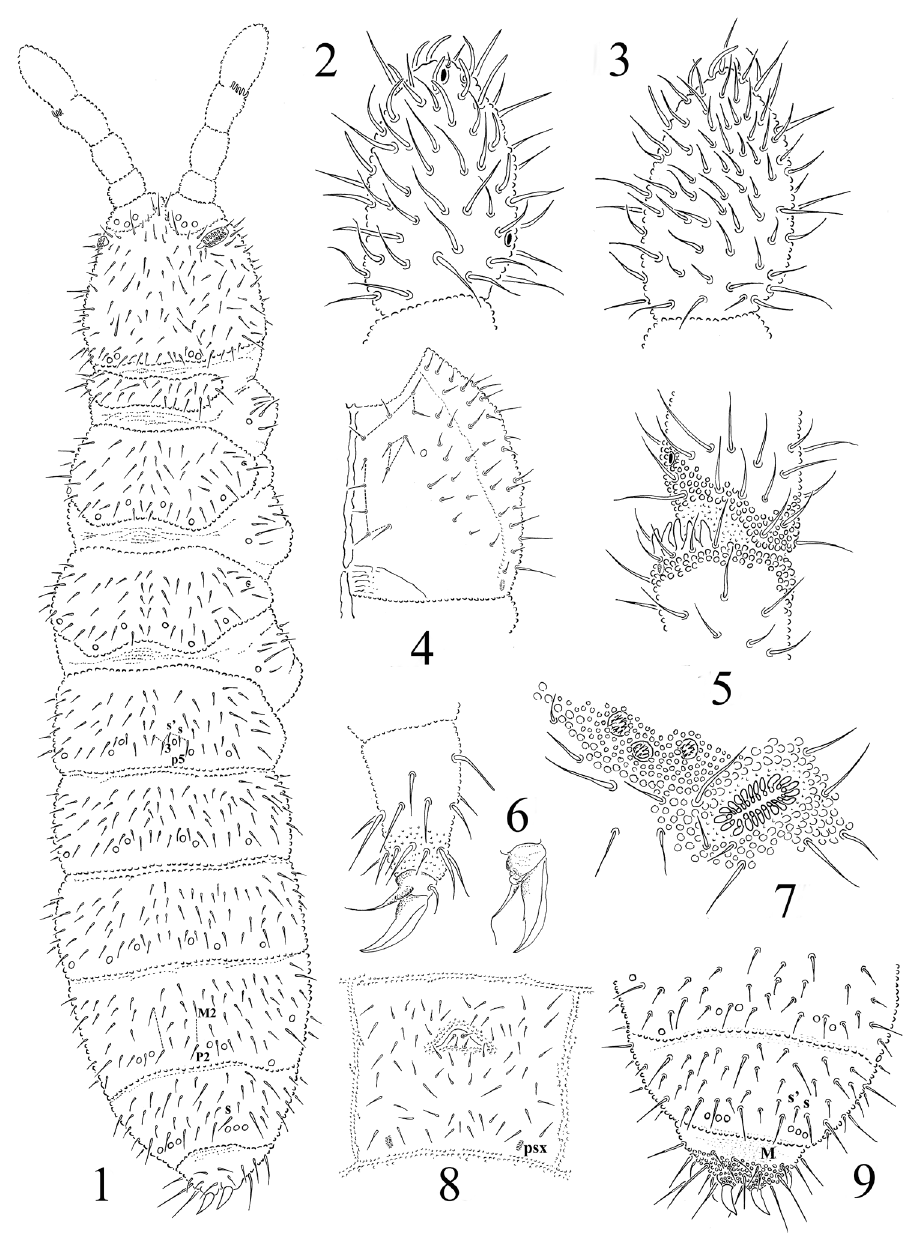
Figures 1–9. Protaphorura abscondita : 1 habitus and dorsal chaetotaxy 2 dorsal side of Ant. IV 3 ventral side of Ant. IV 4 right part of head ventrally 5 AIIIO 6 tibiotarsal chaetotaxy and claw of leg III 7 PAO and anterior cephalic pseudocelli 8 chaetotaxy of Abd. sternum IV 9 chaetotaxy of Abd. terga